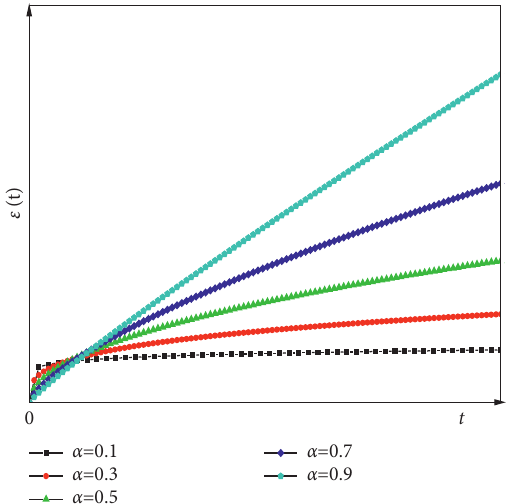
Figure 3: Creep curves of fractional soft component under dif- ferent α.